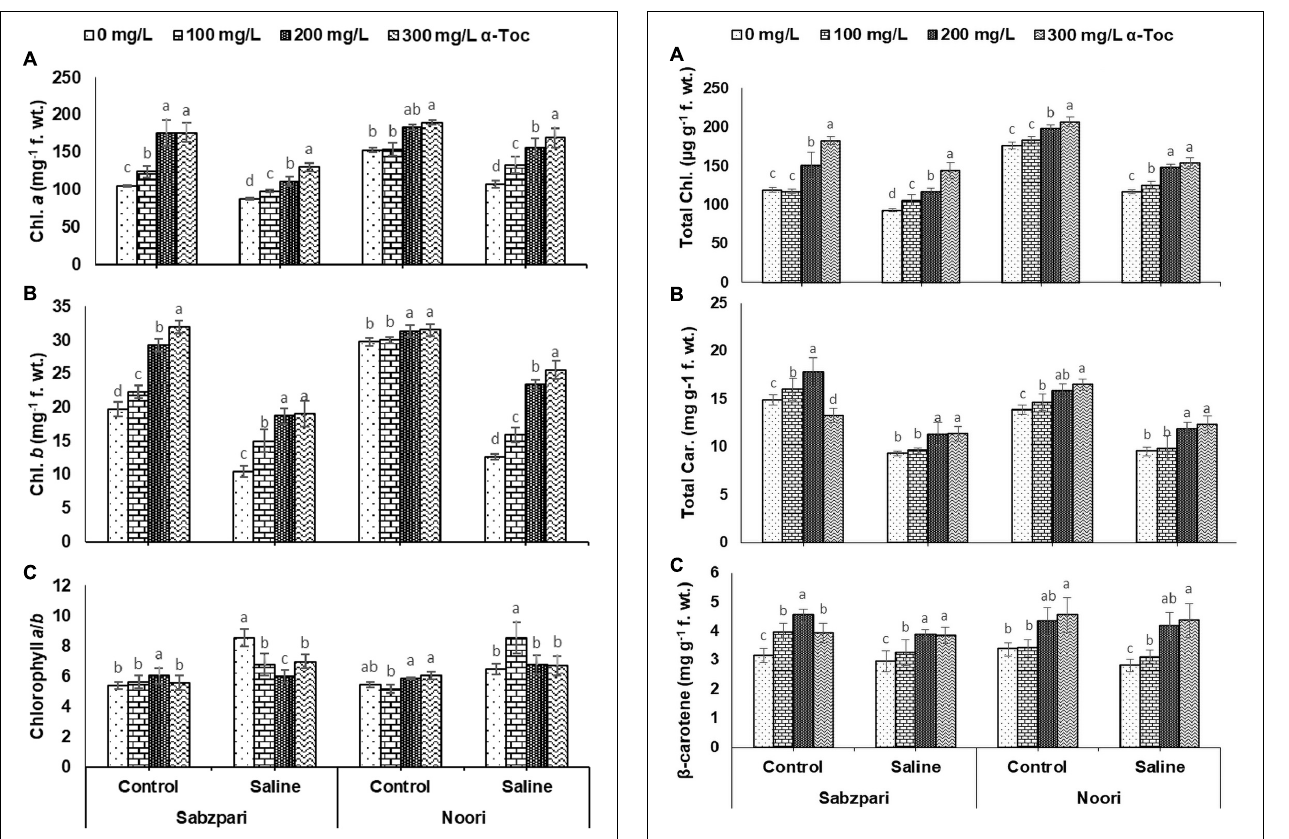
FIGURE 3 | Chl. a (A), Chl. b (B) , Chl. a / b (C) of okra varieties sprayed with different levels of α -tocopherol under saline conditions. Values represent means ± S.D. Significant differences among row spacing were measured by the least significant difference (LSD) at p > 0.05 and indicated by different letters.